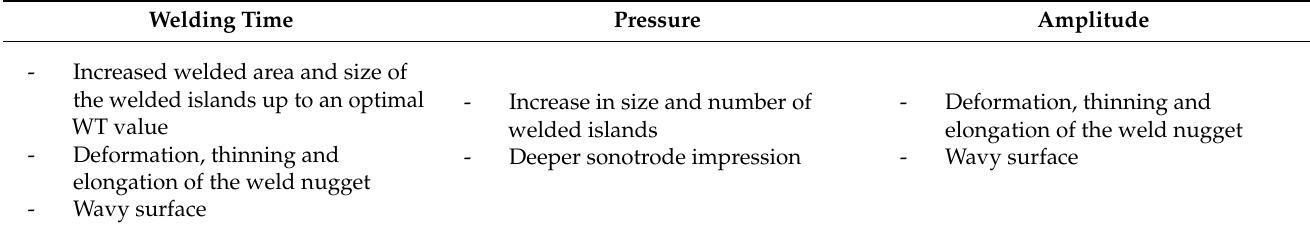
Table 4. Effects of increasing parameter values on the weld